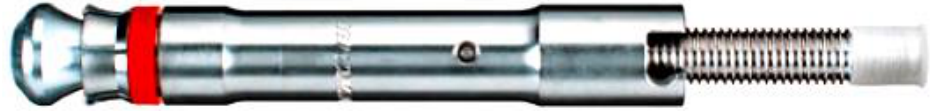
Figure 4. Hilti HDA-P undercut anchor.